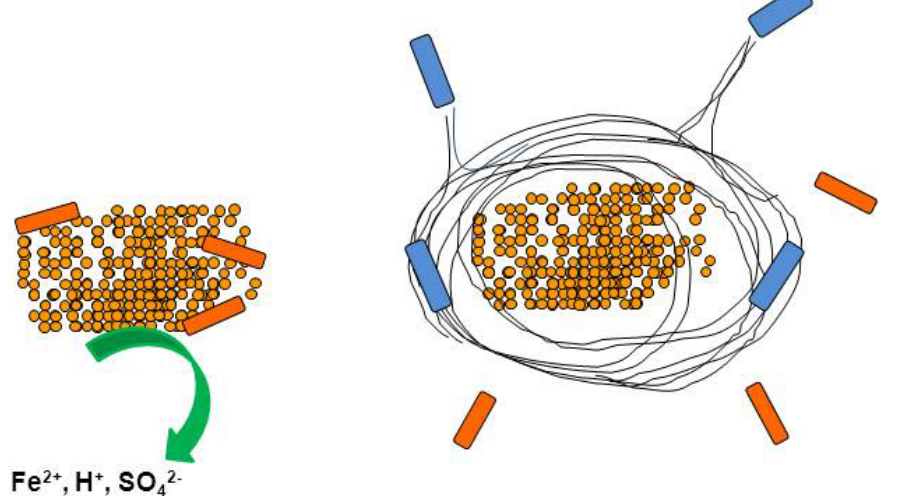
Figure 1. Schematic representation of the “bioshrouding” technique for securing mine tailings [17]. Pyrite particles (depicted in gold) colonized by iron/sulfur-oxidizing bacteria (in red), generating acid mine drainage (AMD) are shown on the left, and the same particles encased with EPS (black lines) produced by heterotrophic acidophiles (in blue) suppressing colonization by iron/sulfur-oxidizing bacteria on the right (not to